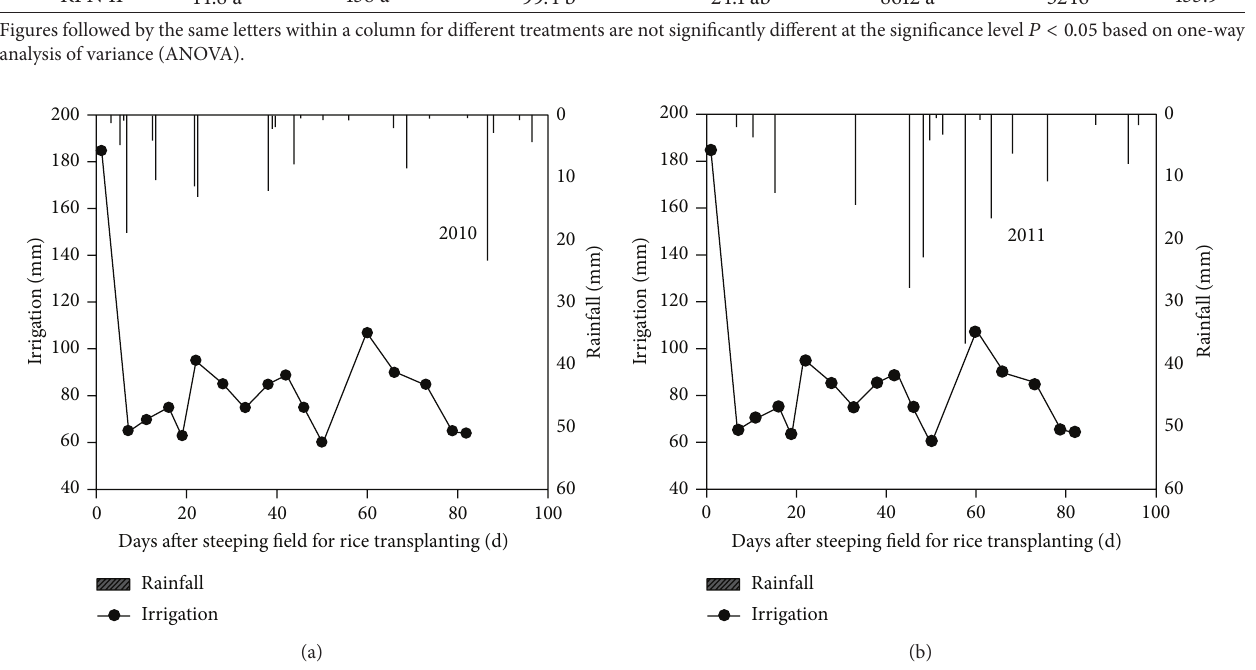
Figure 1: Precipitation and irrigation amount during whole growth period of